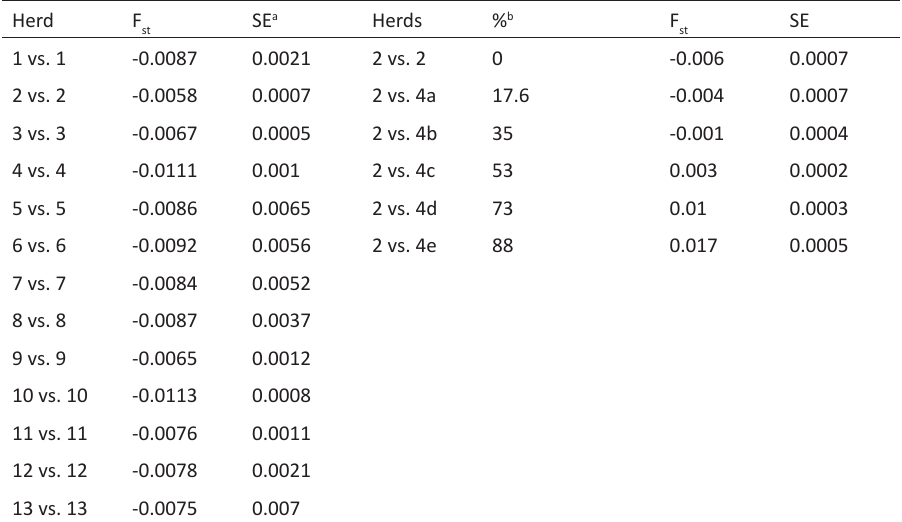
Table 3. F values when a herd is compared to itself and when herd 4 is compared to herd 2 with different st proportions of cows from herd